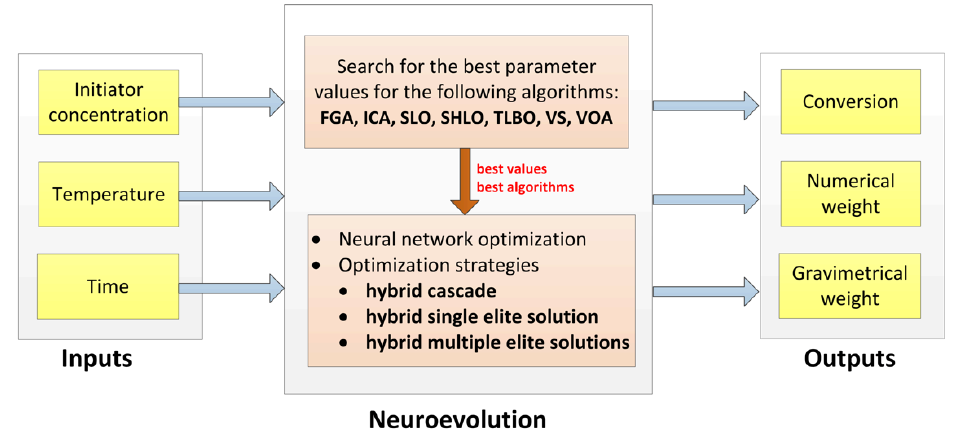
Figure 1. Illustration of the main steps of our approach.